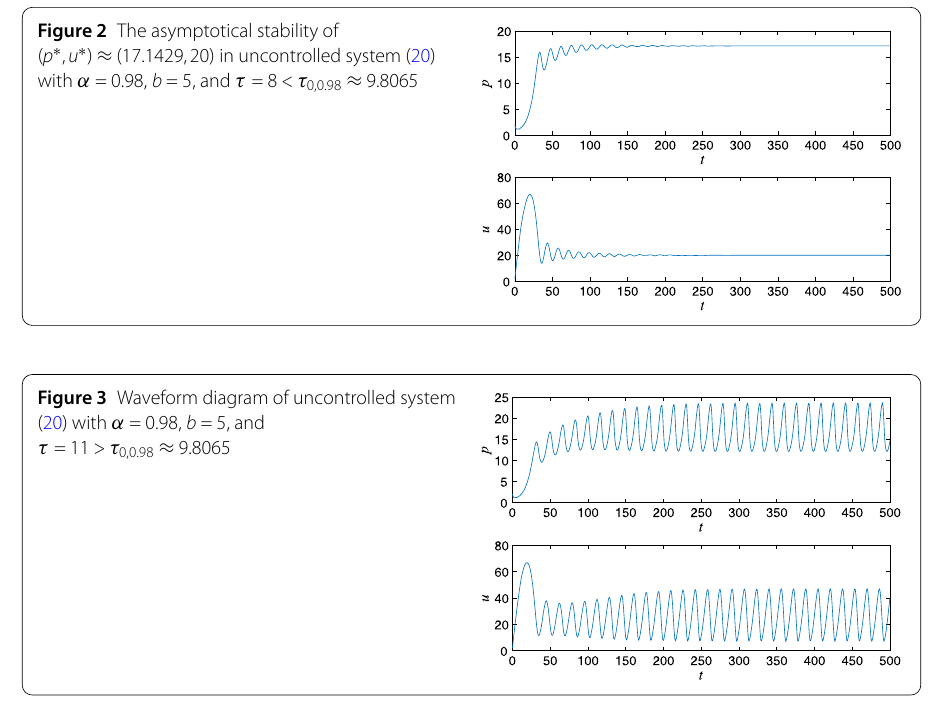
Figure 2 The asymptotical stability of ( p ∗ , u ∗ ) ≈ (17.1429,20) in uncontrolled system (20) with α = 0.98, b = 5, and τ = 8 < τ 0,0.98 ≈ 9.8065